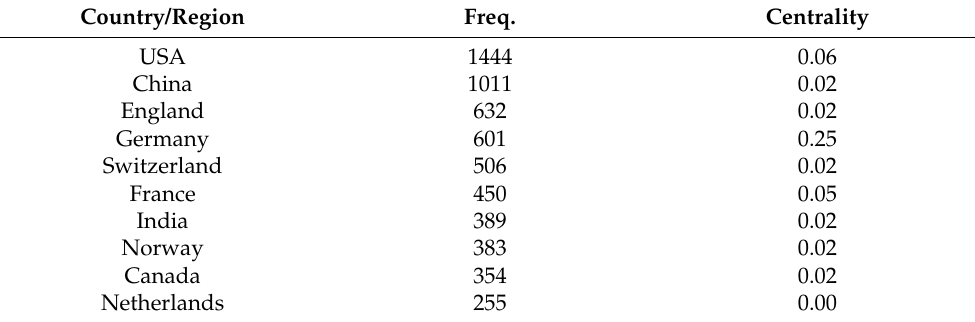
Figure 4. Knowledge map of co-citation authors. Table 5. Top ten countries by number of